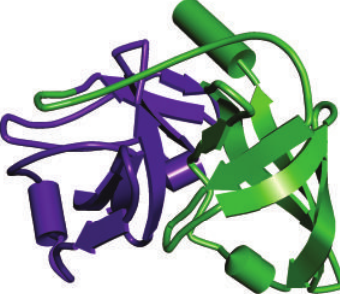
Figure 1: The figure depicts the structure of NS3 protease with schematic model. Violet color shows the N-terminal serine protease domain region in the protein, and green color shows the C-terminal domain region that is a member of the DExH/D-box helicase superfamily II with NTPase